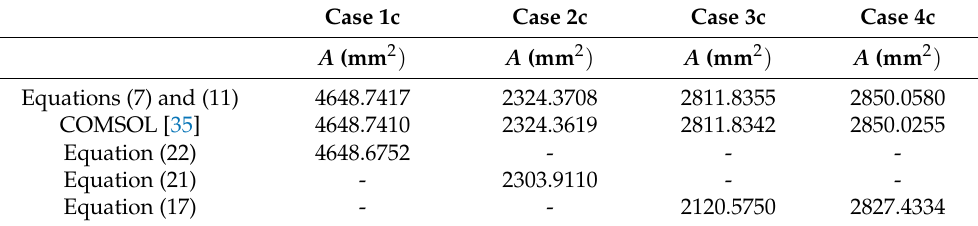
Table 2. Results of intersection areas for primary test configurations.